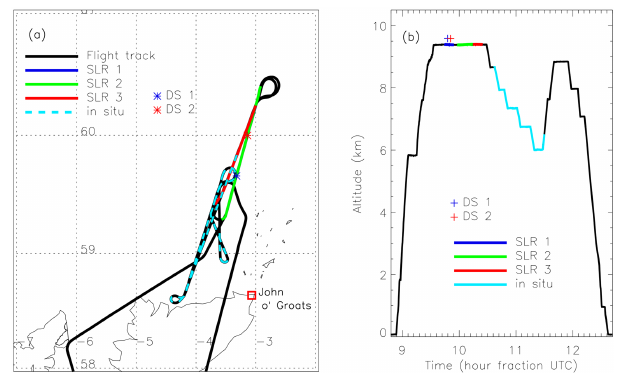
Figure 1. (a) Flight track for FAAM flight B895 (shown in black). The three SLRs are shown in colour; note that SLR-1 lies directly beneath SLR-2 and is, therefore, not visible. The deployment of dropsondes (DS) 1 and 2 are indicated along with the period fol- lowing SLR 3 when in situ sampling of the cloud layer was per- formed. (b) Aircraft altitude as a function of time, with the three SLRs and in situ measurement phases shown as well as the DS 1 and 2 deployment